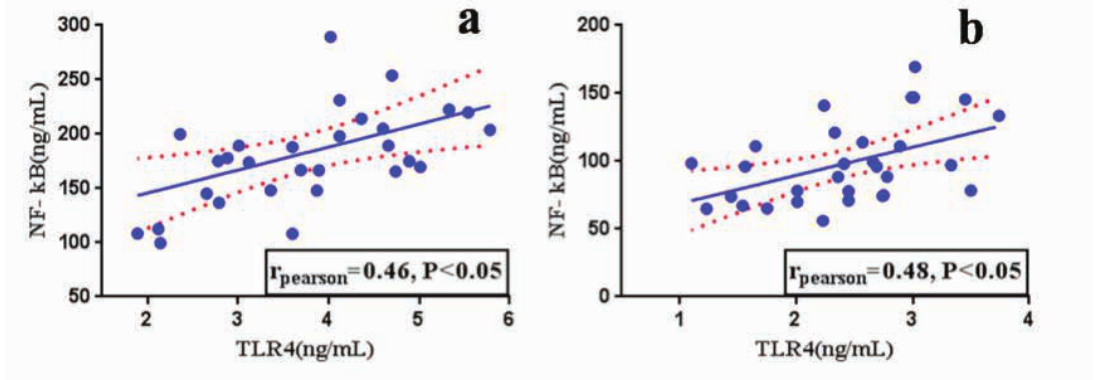
Figure 1: Pearson correlation analysis of TLR4 and NF-κBp65.(a: for preeclampsia patients; b: for normal pregnant